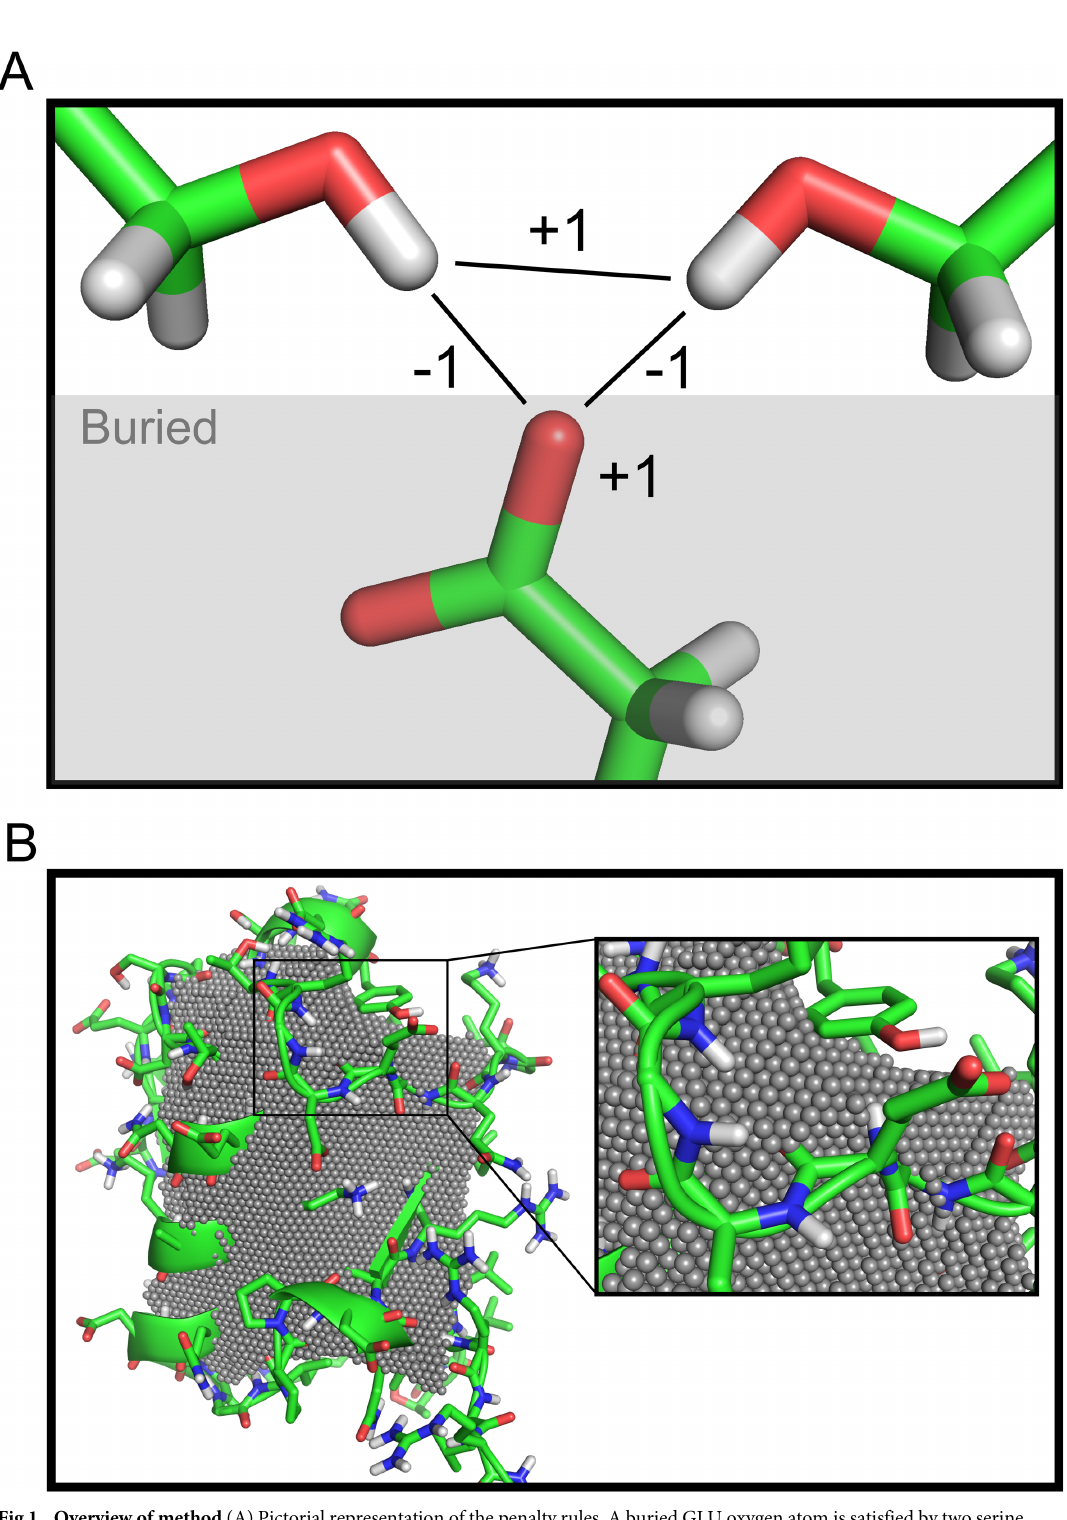
Fig 1. Overview of method (A) Pictorial representation of the penalty rules. A buried GLU oxygen atom is satisfied by two serine hydroxyls. An oversaturation penalty is applied to the two hydroxyls. In this example: β = 1, σ = -1, ω = 1. (B) Burial region calculation applied to Ubiquitin (PDB: 1UBQ)[6]. Grey spheres indicate the buried region at 4.5 Å depth from the poly-LEU molecular surface with a 2.3 Å probe size and were generated using PyRosetta[7]. Images generated with PyMOL[8].